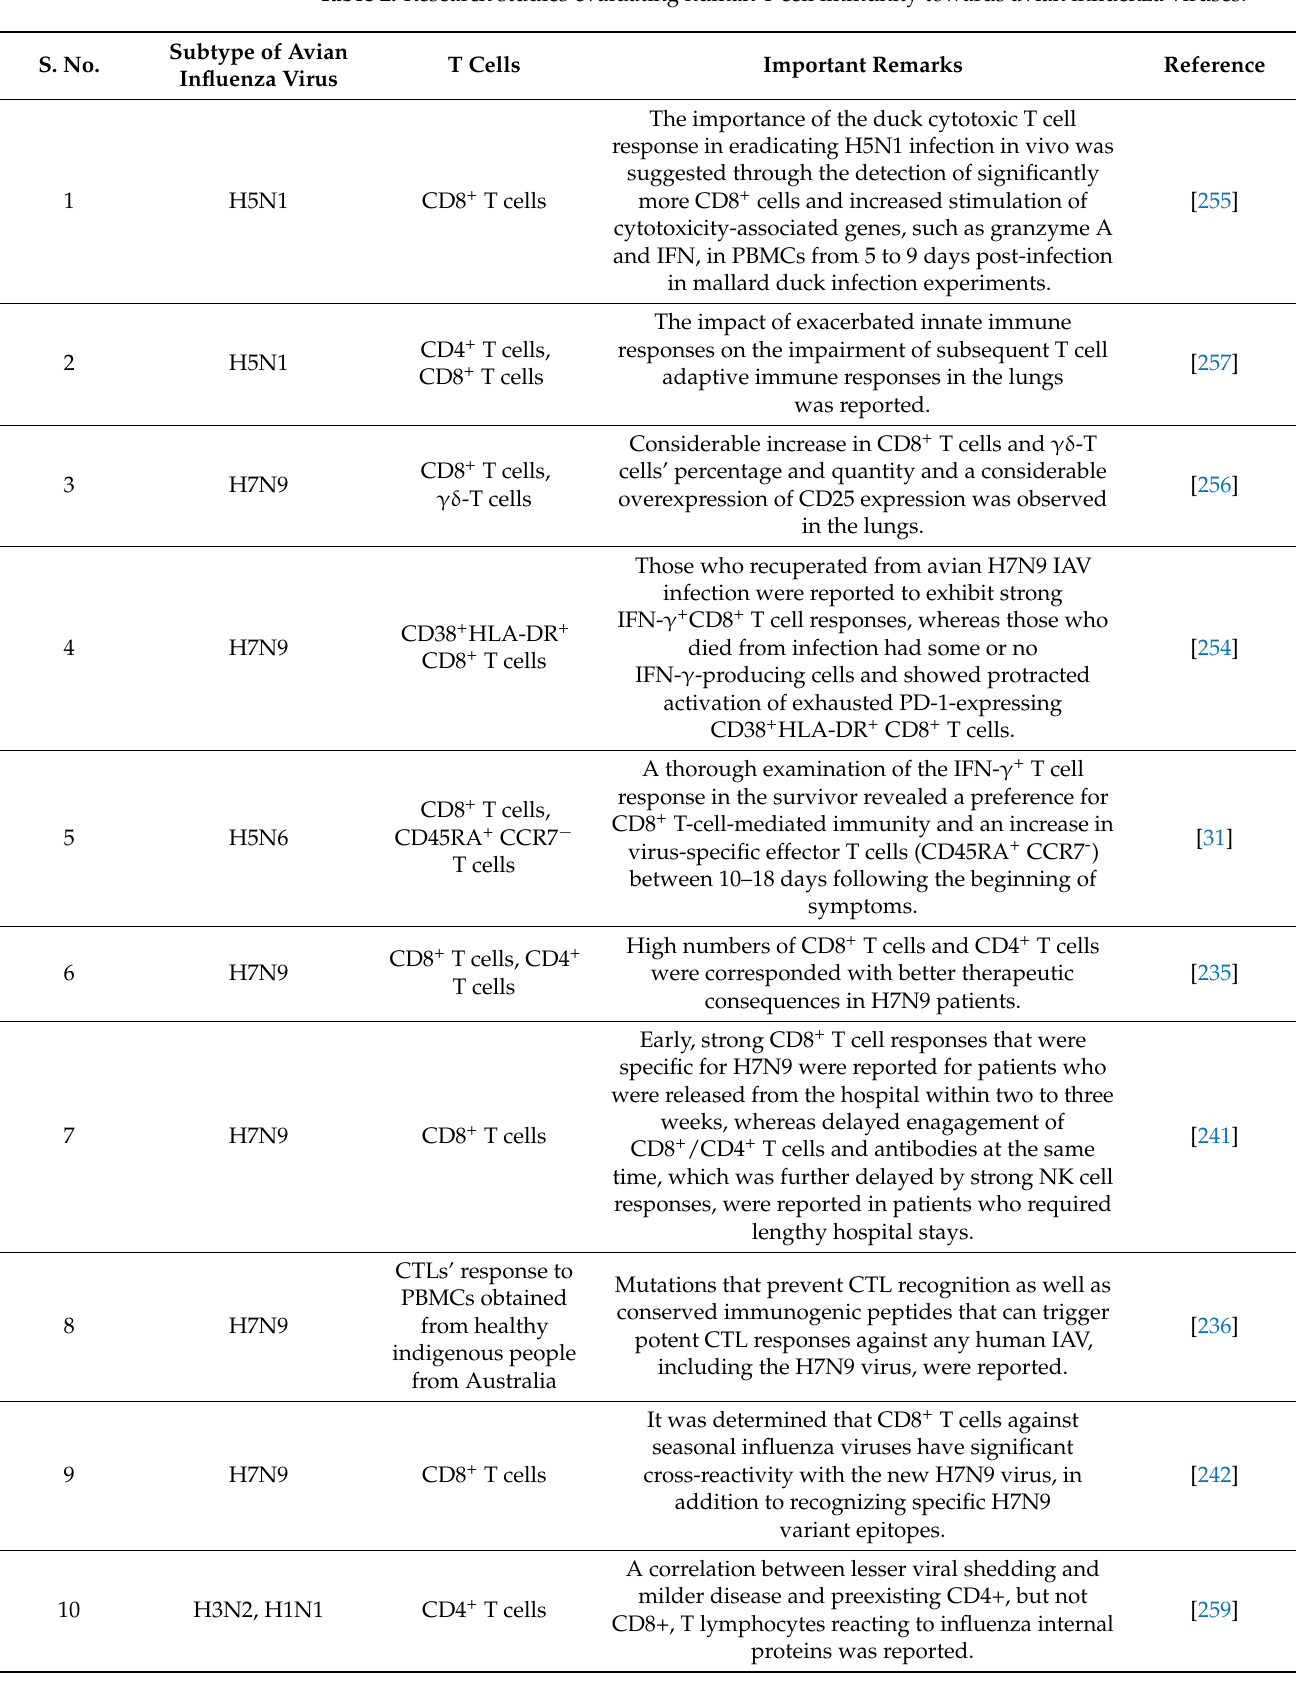
Table 2. Research studies evaluating human T cell immunity towards avian influenza viruses. S.